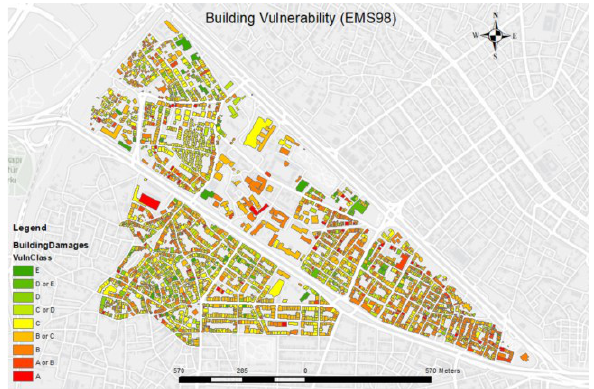
Figure 7 . Building vulnerability. Source: de Vries, 2022 Almost half (43.8%) of the buildings with damage grade 4 are located in Molla Gürani, where also 21.8% of the buildings with damage grade 3 are located. Within the neighbourhood 65.4% of the buildings receive damage grade 4. In Sehremini 36.7% of the buildings with damage grade 4 and 44.5% with grade 3 are located. Both buildings with damage grades 3 and 4 are almost equally present. Only 19.4% of buildings with damage grade 4 and 33.6% with damage grade 3 are located in Topkapi. Within the neighbourhood 52.0% of the buildings show to receive damage grade 3. Based on this, it can be said that the buildings in Molla Gürani are most at risk to receiving building damage.